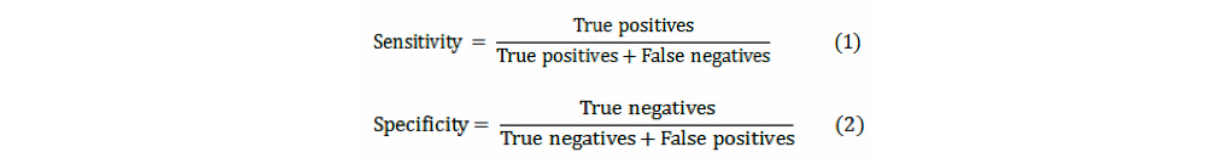
Figure 3. Sensitivity and specificity.